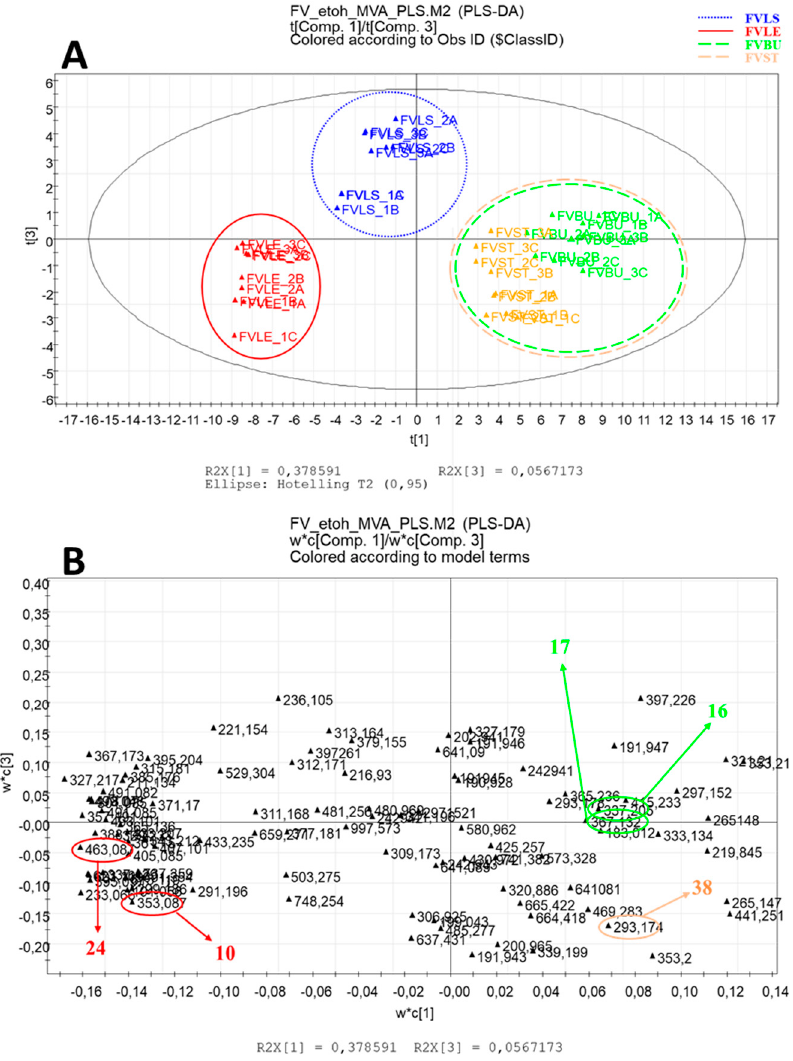
Figure 3. Partial Least Squares Discriminant Analysis (PLS-DA) of ethanolic extracts of F. vulgare . ( A ) score scatter plot; ( B ) loading plot with identifications of biomarkers.